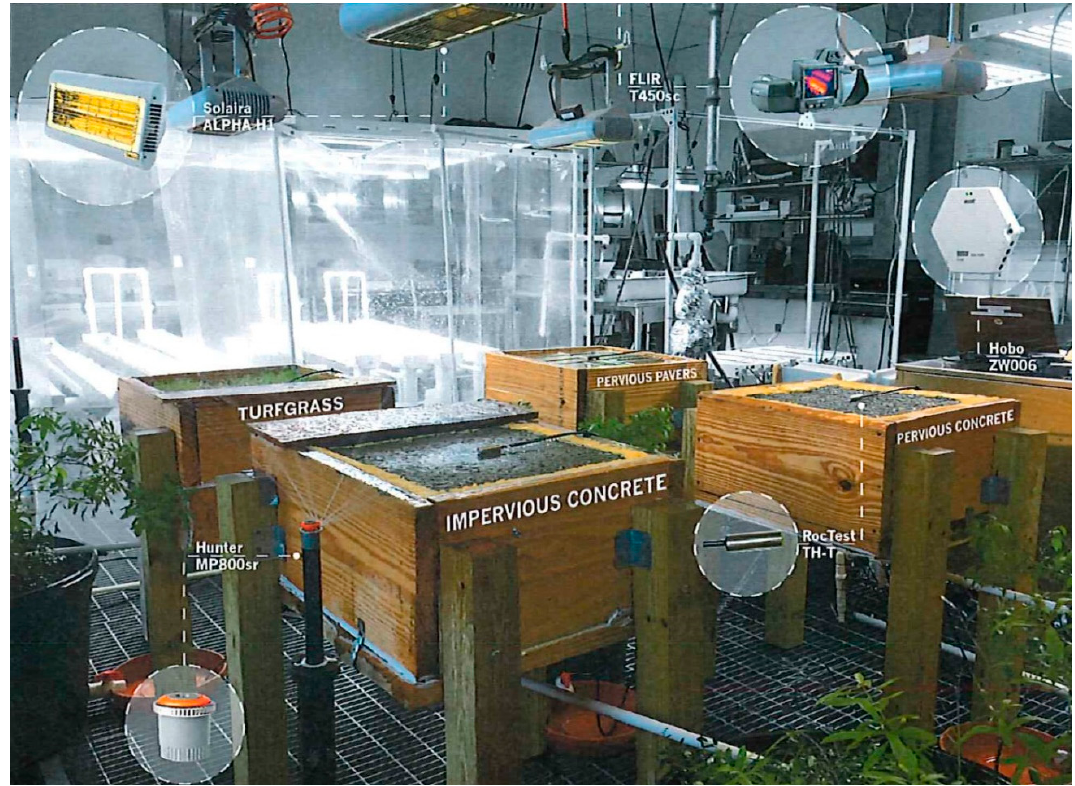
Figure 1. Layout of the Green Infrastructure Laboratory at the Mike Hubbard Center for Advanced Science, Innovation and Commerce (CASIC) Building at Auburn University, Auburn, AL, USA [52].